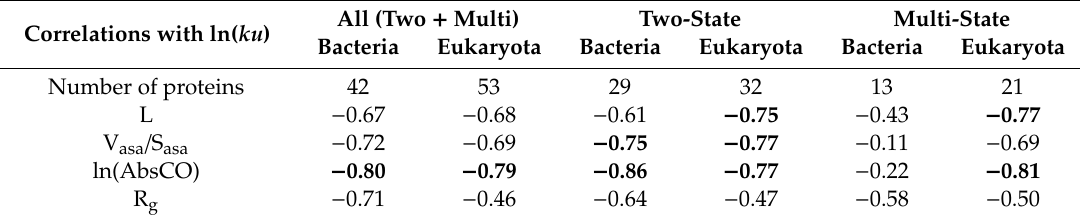
Table 6. Correlations between the logarithm of the unfolding rate (ln( ku )) and structural parameters (L, V asa /S asa , ln(AbsCO), and R g ) for two-state and multi-state bacterial and eukaryotic proteins. Correlations with All (two + multi) Two − state Multi − state ln( ku ) Bacteria Eukaryota Bacteria Eukaryota Bacteria Eukaryota Number of proteins 42 53 29 32 13 21 L − 0.67 − 0.68 − 0.61 − 0.75 − 0.43 − 0.77 V asa / S asa − 0.72 − 0.69 − 0.75 − 0.77 − 0.11 − 0.69 ln(AbsCO) − 0.80 − 0.79 − 0.86 − 0.77 − 0.22 − 0.81 R g − 0.71 − 0.46 − 0.64 − 0.47 − 0.58 − 0.50 * Correlations above 0.75 are shown in bold.